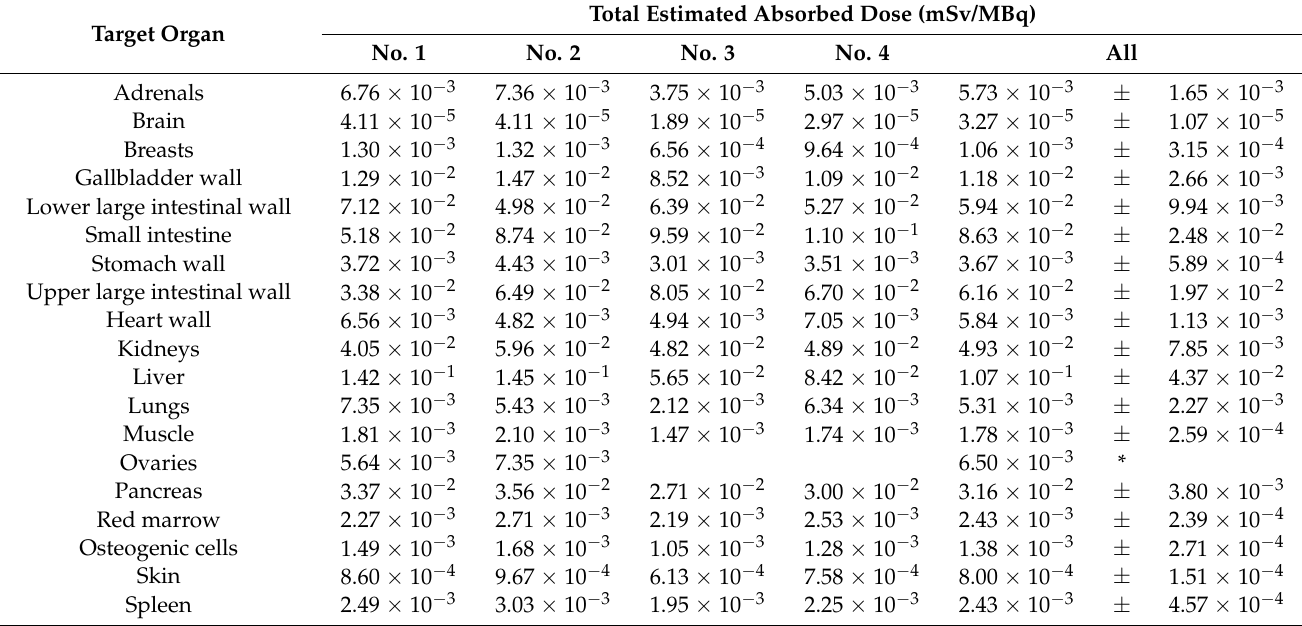
Figure 6. Time–activity curves of intraperitoneally administrated 64 Cu-NCAB001 in key organs of monkeys. Data are shown as the %injected dose (ID)/g for each organ. Table 2. Human absorbed doses of intraperitoneally administrated 64 Cu-NCAB001: estimated from monkey biodistribu- tion.